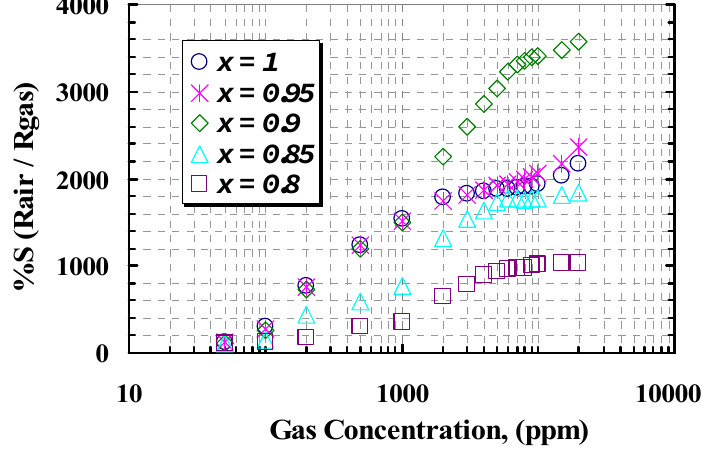
Figure 14 . Sensitivity of samples to different concentrations of C operating temperatures of 395 °C ( x = 1), 385 °C ( x = 0.95), 370 °C ( x = 0.9), 430 °C ( x = 0.85), and 440 °C ( x = 0.80).